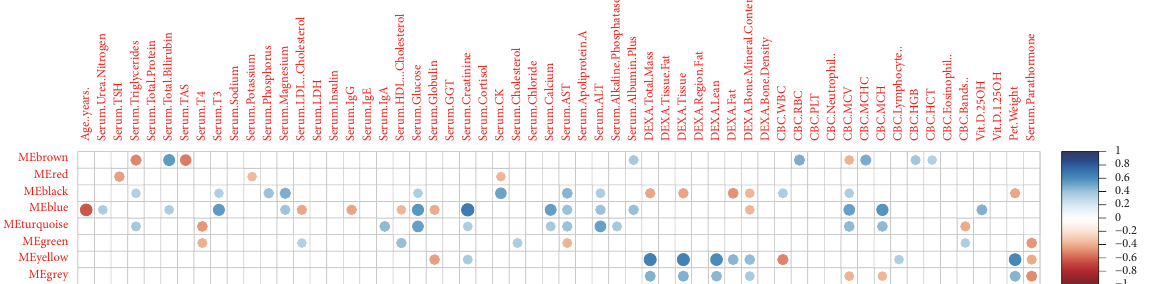
Figure 4: Correlations between metabolite modules and clinical parameters. Significant associations ( 𝑃 < 0.05) between metabolite modules and clinical parameters using small dogs as reference are indicated by filled circles. Strength of Spearman correlations detailed by the scale on the